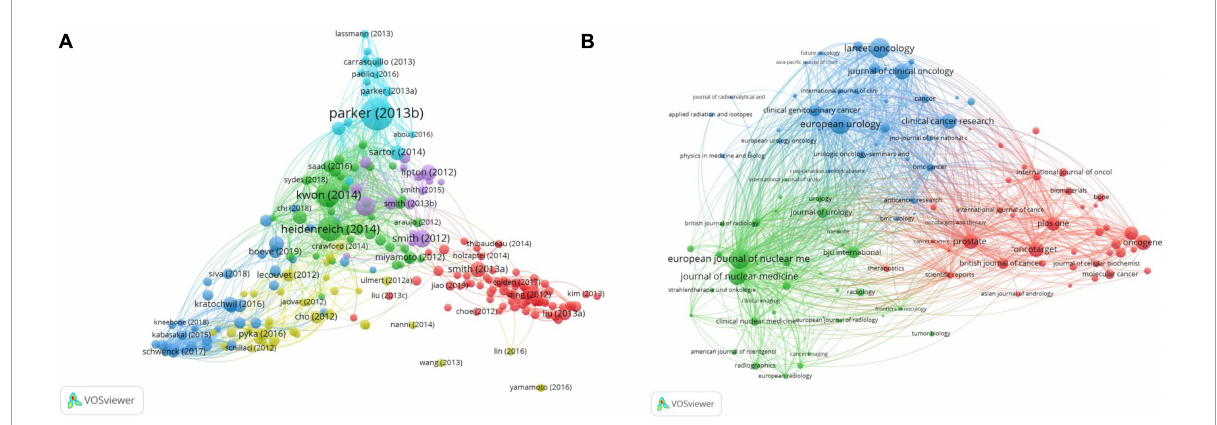
FIGURE8 The bibliometric analysis of the bibliographic coupling in the field of PCa bone metastasis. (A) The network visualization map of bibliographic coupling of articles in the field of PCa bone metastasis. (B) The network visualization map of bibliographic coupling of journals in the field of PCa bone